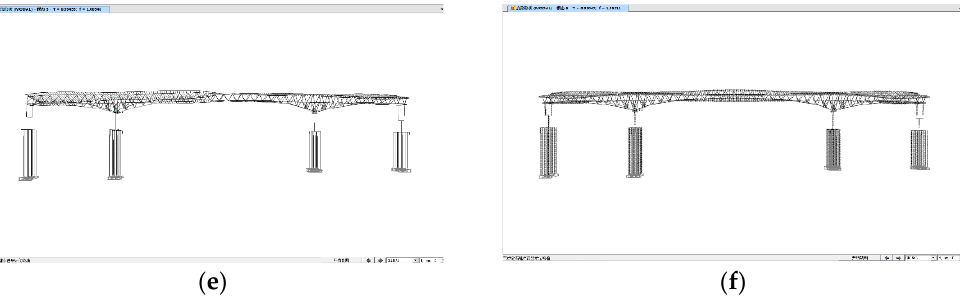
Figure 7. Front six modes. ( a ) First mode. ( b ) Second mode. ( c ) Third mode. ( d ) Fourth mode. ( e ) Fifth mode. ( f ) Sixth mode. Table 1. The natural frequency value of each order.